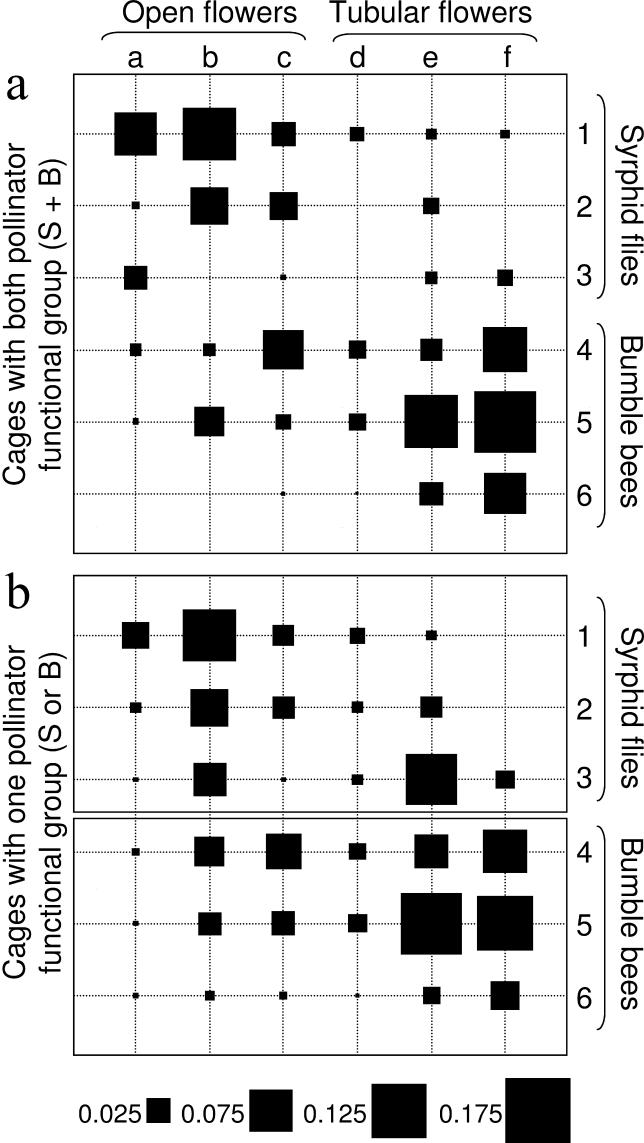
Visitation Web in the Communities with Both Plant TypesDistribution of pollinator visits for the year 2003, among the six plant species in the plant treatment containing the two plant functional groups, (A) for the mixed pollination treatment (S + B) and (B) for the single functional group pollination treatments (S or B). The length of the side of the black squares shows the proportion of visits by a given pollinator species on each plant species. Lower-case letters represent plant species: a, Ma. officinalis; b, E. cicutarium; c, R. raphanistrum; d, Mi.guttatus; e, Me. sativa; f, L. corniculatus. Numbers represent pollinator species: 1, Saephoria sp.; 2, Ep. balteatus; 3, Er. tenax; 4, B. terrestris; 5, B. pascuorum; 6, B. lapidarius.